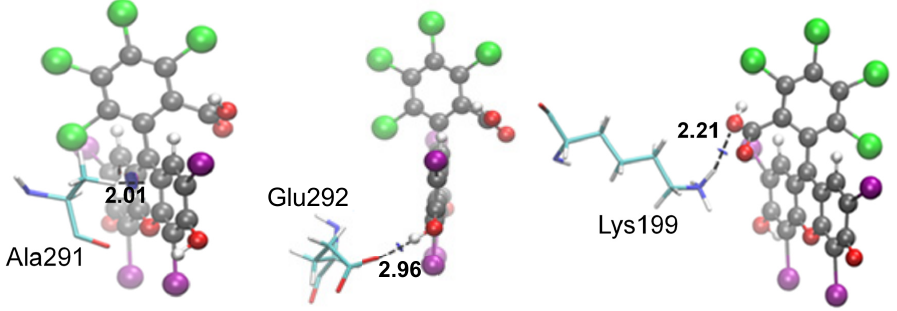
Figure 6. Figure 6. Interactions of RB dye to HSA DS1 obtained in NCIplot studies and analyzed by VMD software.